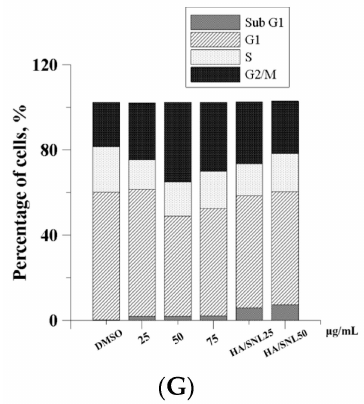
Figure 10. PI staining-based cell cycle analysis of A549 cells treated with DMSO, SNL, and HA/SNL